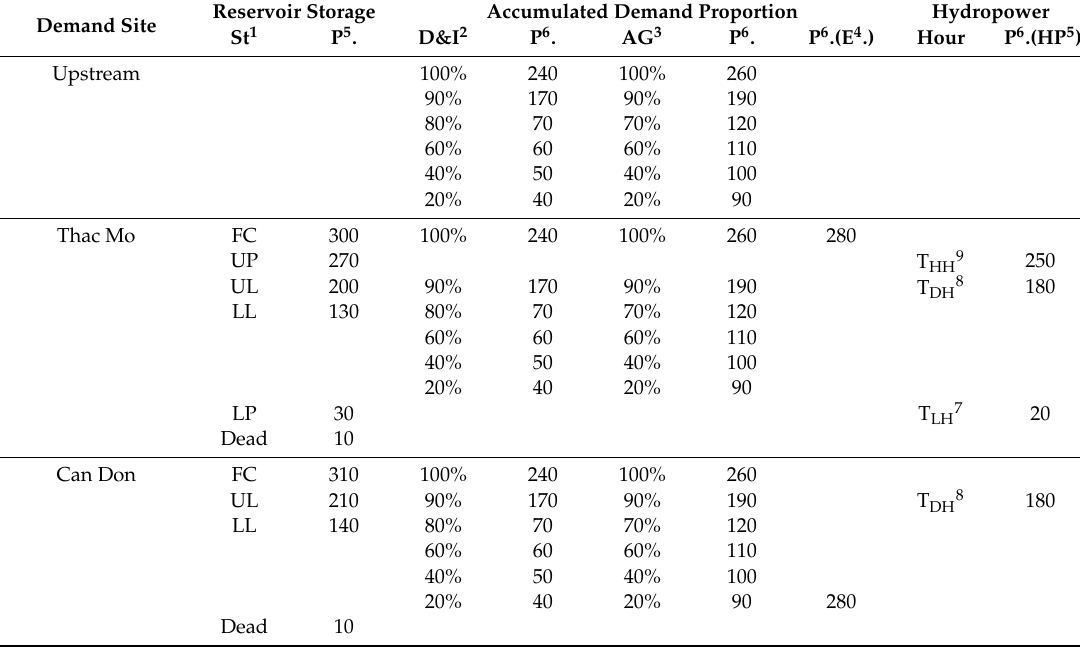
Table 2. Allocation priorities of fractional demands and reservoir storage